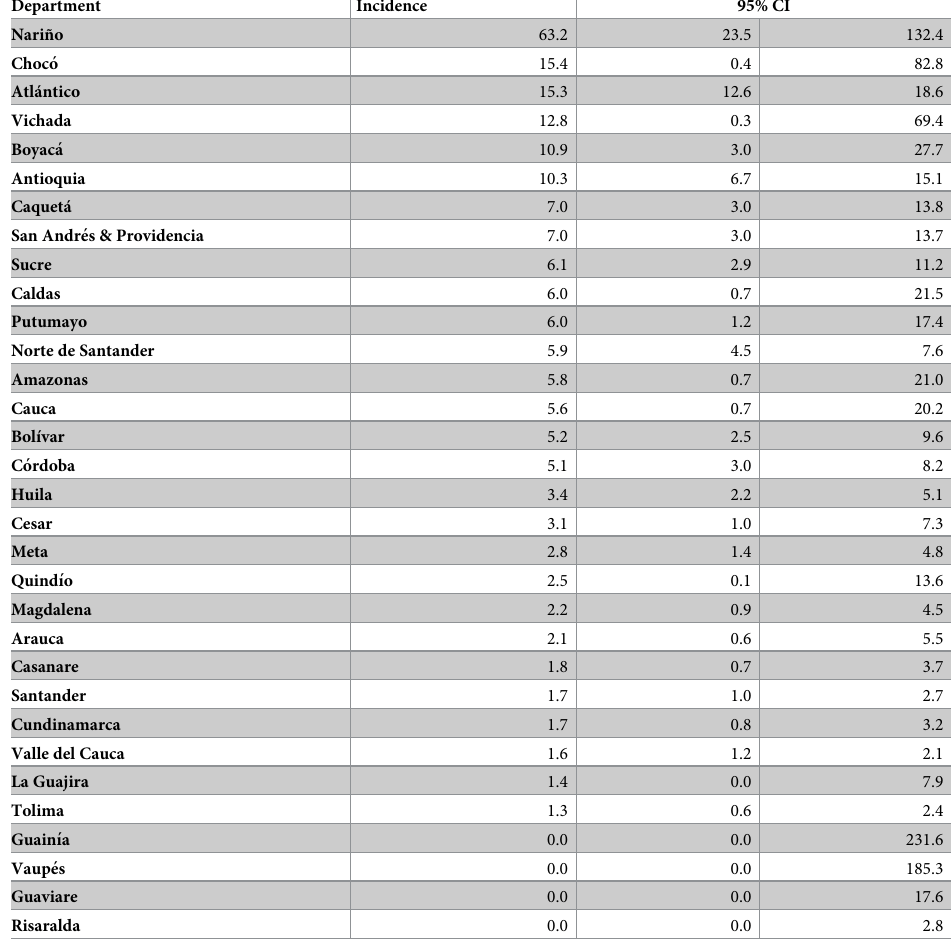
Table 2. Cumulative incidence and 95% confidence intervals of ZIKV-associated neurological complications per 1,000 ZVD cases by department in Colombia. Department